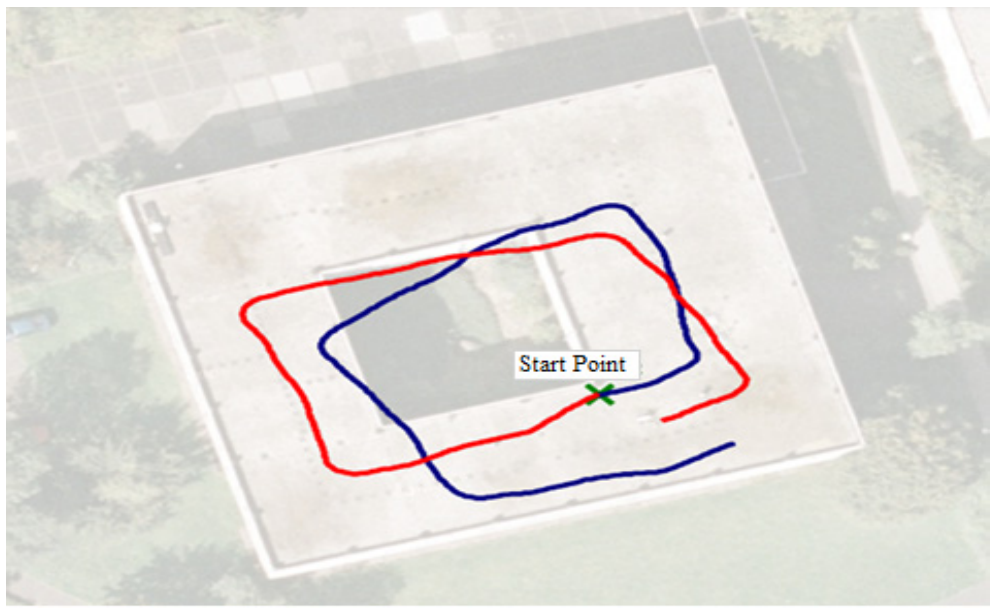
Figure 9. Self-estimates of robot position.